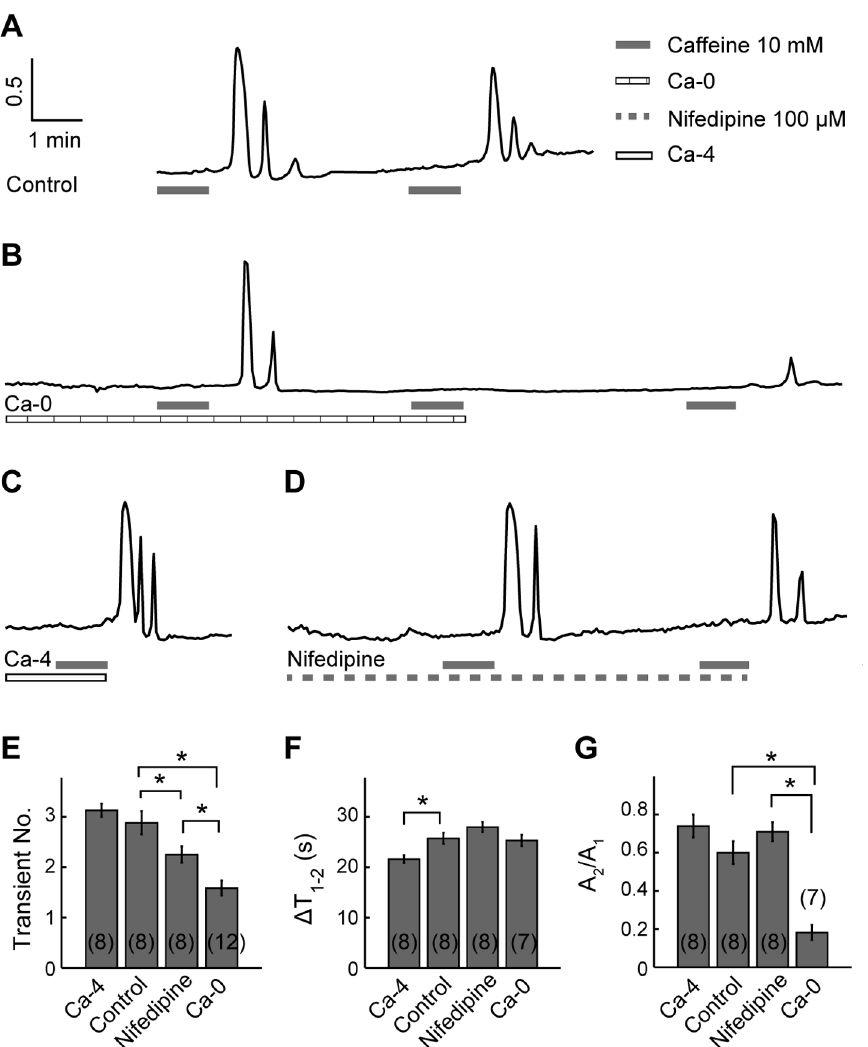
Figure 3. Regulation of [Ca 2 + ] o entry affects the caffeine-induced [Ca 2 + ] i oscillations. A–D, caffeine (10 mM, 60 s) induced [Ca 2 + ] i oscillations in: (A) normal Ringer’s solution (control) and Ringer’s solution with (B) Ca 2 + -free, (C) 4 mM [Ca 2 + ] o , and (D) nifedipine (100 m M). E–G, The average number of [Ca 2 + ] i transients (E), D T 1–2 (F), and A 2 /A 1 (G) of caffeine (10 mM, 60 s) induced [Ca 2 + ] i oscillations for the 4 mM [Ca 2 + ] o group, the control group, the nifedipine group, and the Ca 2 + -free group. * denotes statistical significance of p , 0.05 with independent-samples t test. Abbreviations: Ca-0: Ca 2 + -free; Ca-4:4 mM [Ca 2 + ] o .